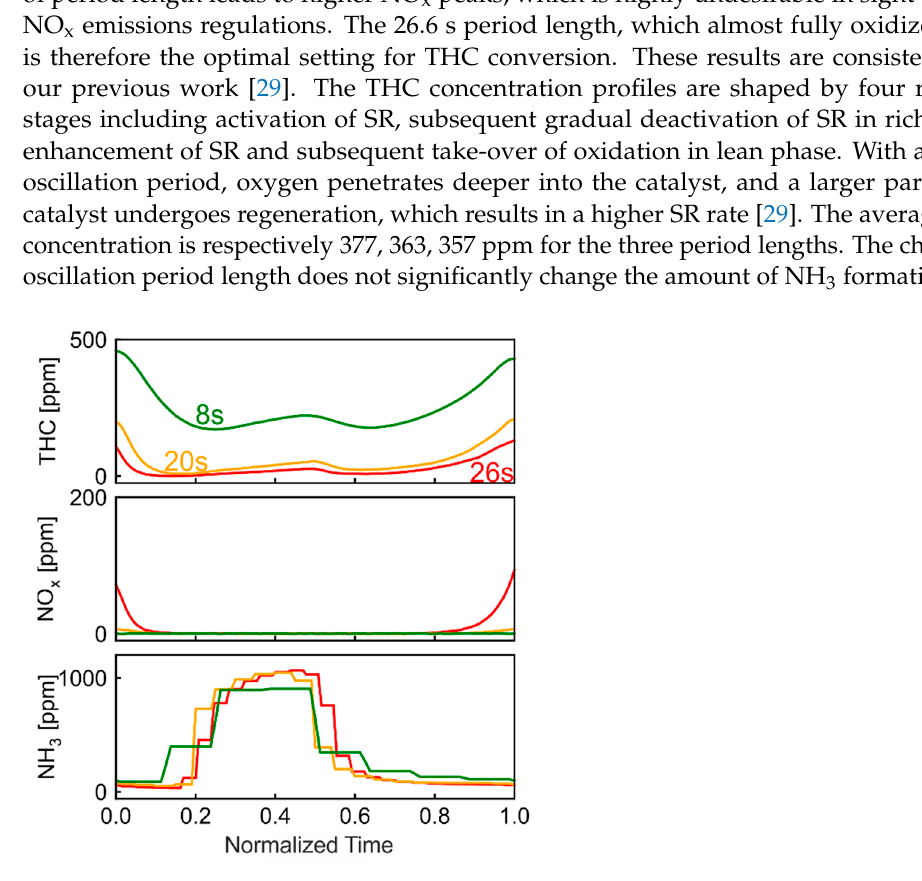
Figure 12. THC, NO x and NH 3 concentration profiles during oscillations with period length of 8 s, 20 s and 26 s.